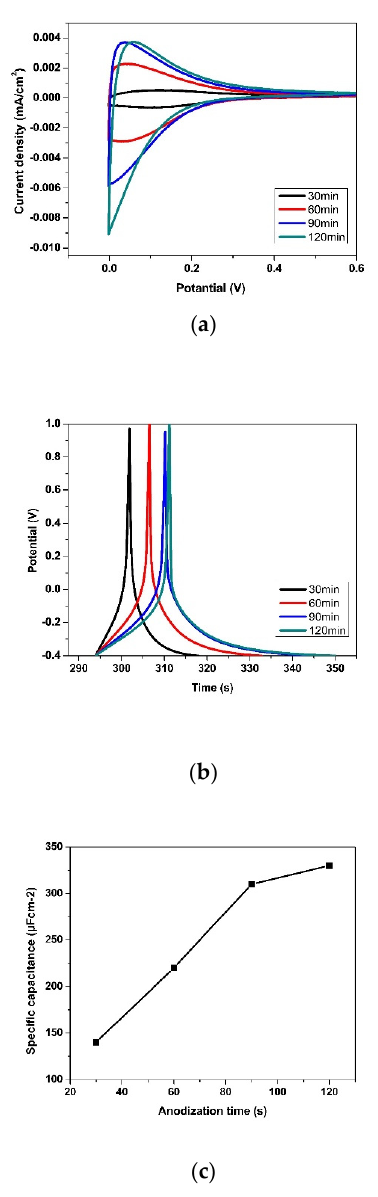
Figure 6. ( a ) CV curves at scan rate of 20 mV s − 1 , ( b ) GCD curves of TNTs at di ff erent anodization time at current density of 0.02 mA cm − 2 and ( c ) variation of SC with anodization